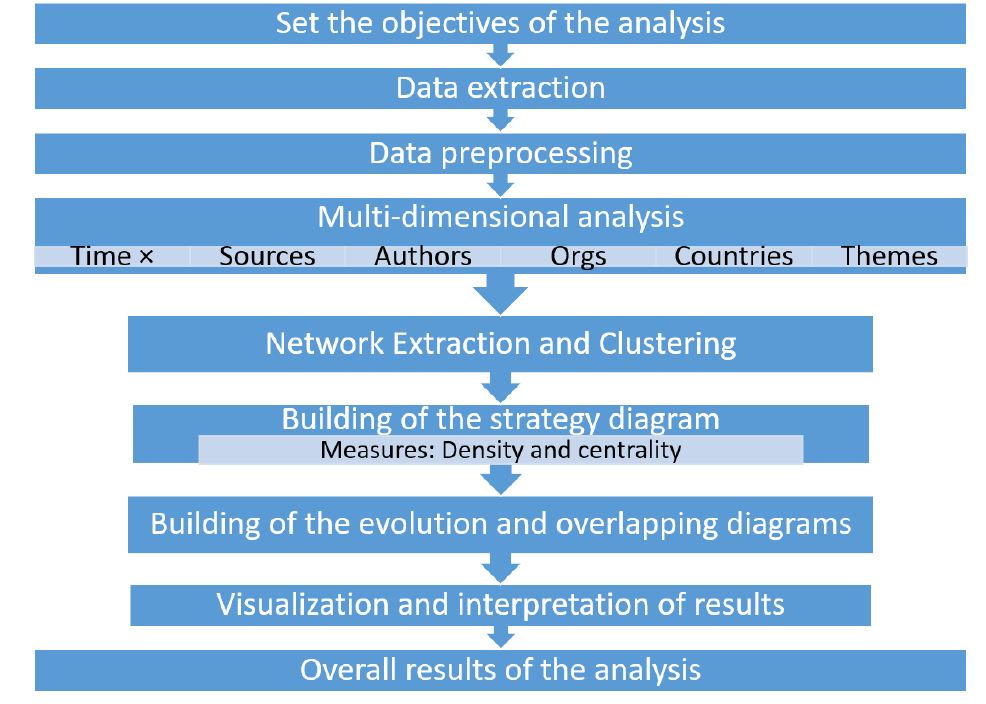
Figure 2. Steps used in the research